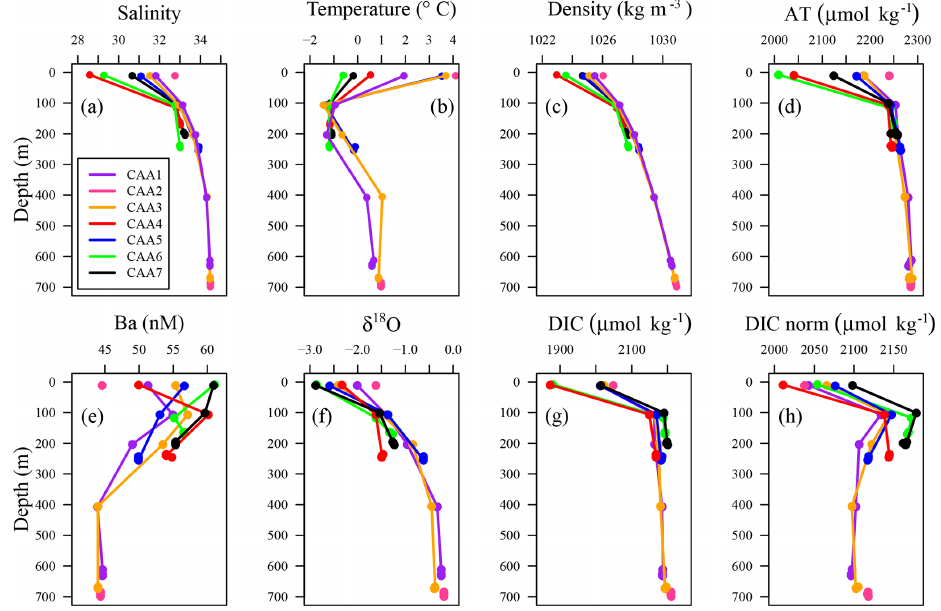
Figure 2. Vertical distributions of (a) practical salinity, (b) temperature, (c) density, (d) AT, (e) Ba, (f) δ 18 O, (g) DIC, and (h) normalized DIC (DIC norm ) observed at stations CAA1 to CAA7 throughout the CAA.